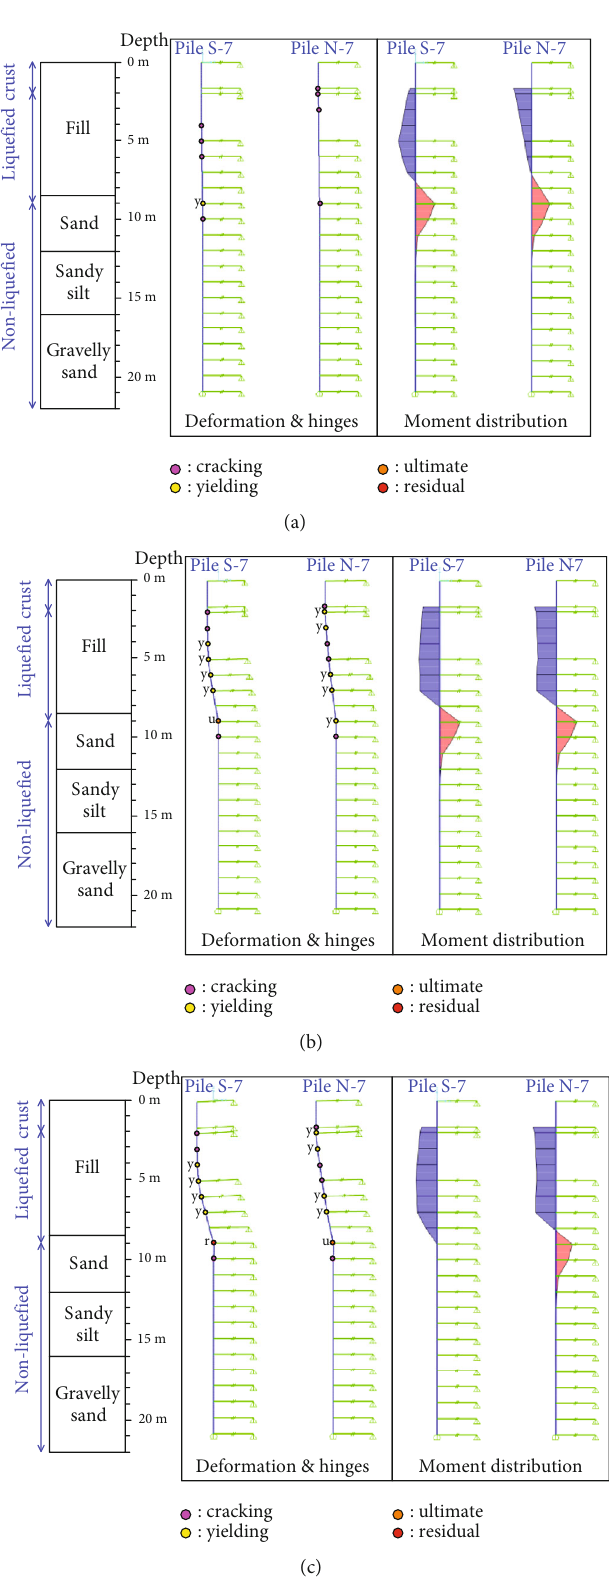
Figure 7: Deformation, plastic hinges, and moment distribution along the piles (lateral spreading as fl ow displacement, no axial load). (a) Yielding state. (b) Ultimate state. (c) Final